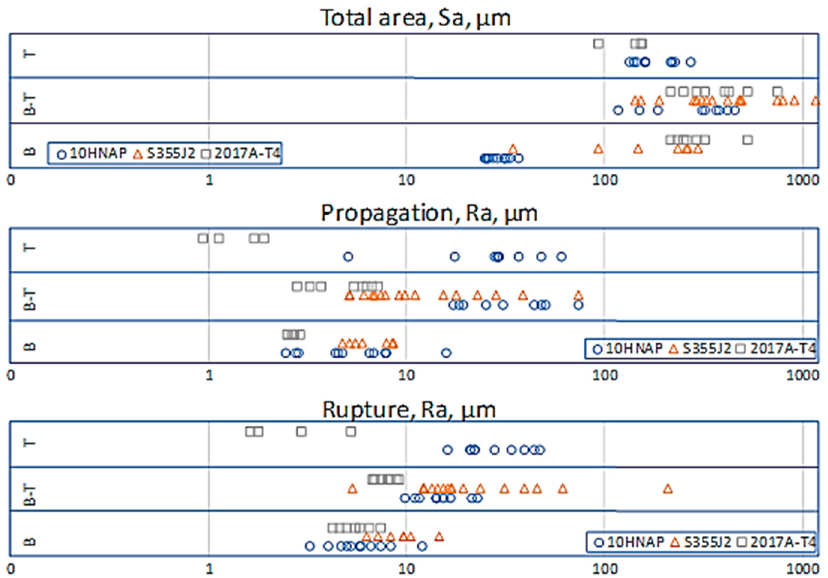
Figure 8. Results for Ra and Sa by type of loading.